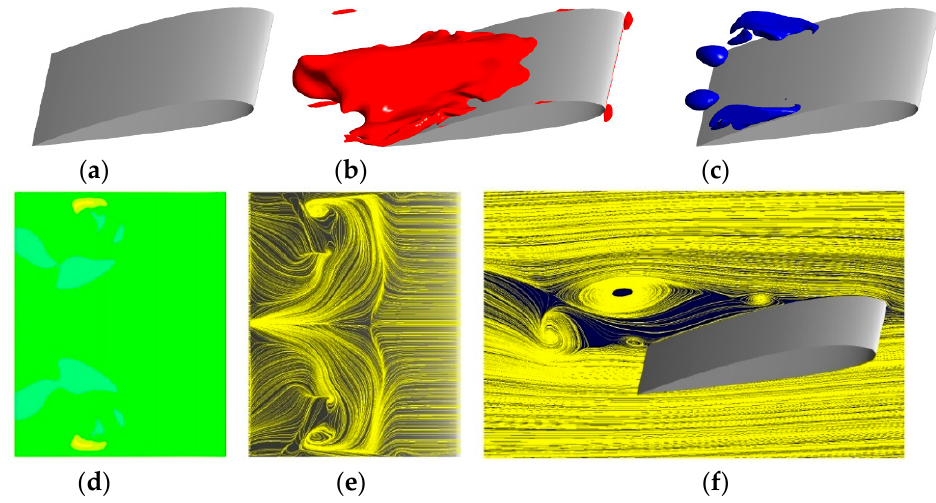
Figure 24. Time instant 4. ( a ) 3D view of cavitation regions (in white); ( b ) back-flow regions (in red); ( c ) evaporation regions (in light cyan) and condensation regions (in dark blue); ( d ) temperature differences on hydrofoil suction side; ( e ) vector lines on hydrofoil suction side; ( f ) vector lines in symmetry plane.